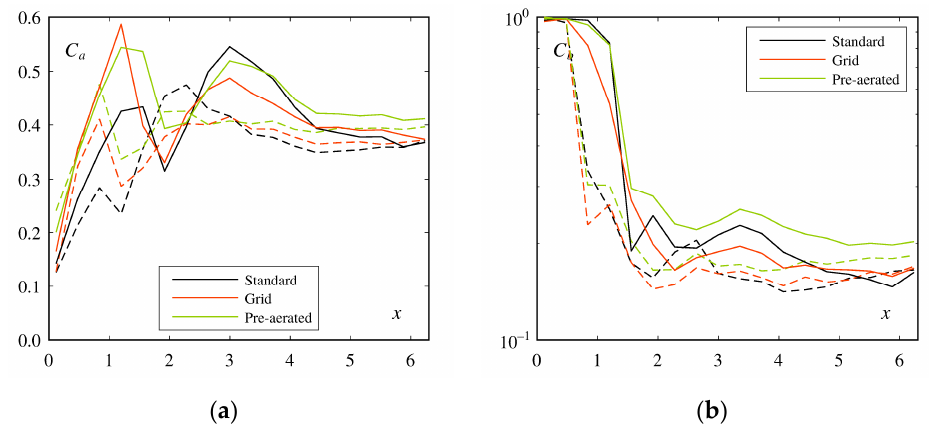
Figure 14. Development of ( a ) the average air concentration C a , and ( b ) the bottom air concentration C b along the stream-wise coordinate x (m) for the standard, the grid and the pre-aerated tests. Continues lines (——) are tests at F o = 7.3–7.5 and dashed lines (– – –) are tests at F o = 5.5. The bottom air concentration C b was decreased at the minimum C b4 and maximum C b5 compared to the standard tests (Figure 14b). For the pre-aerated tests, C b was increased at the minimum C b4 and there was no clear trend for the maximum C b5 (decrease for F o = 5.5 and increase for F o = 7.5).